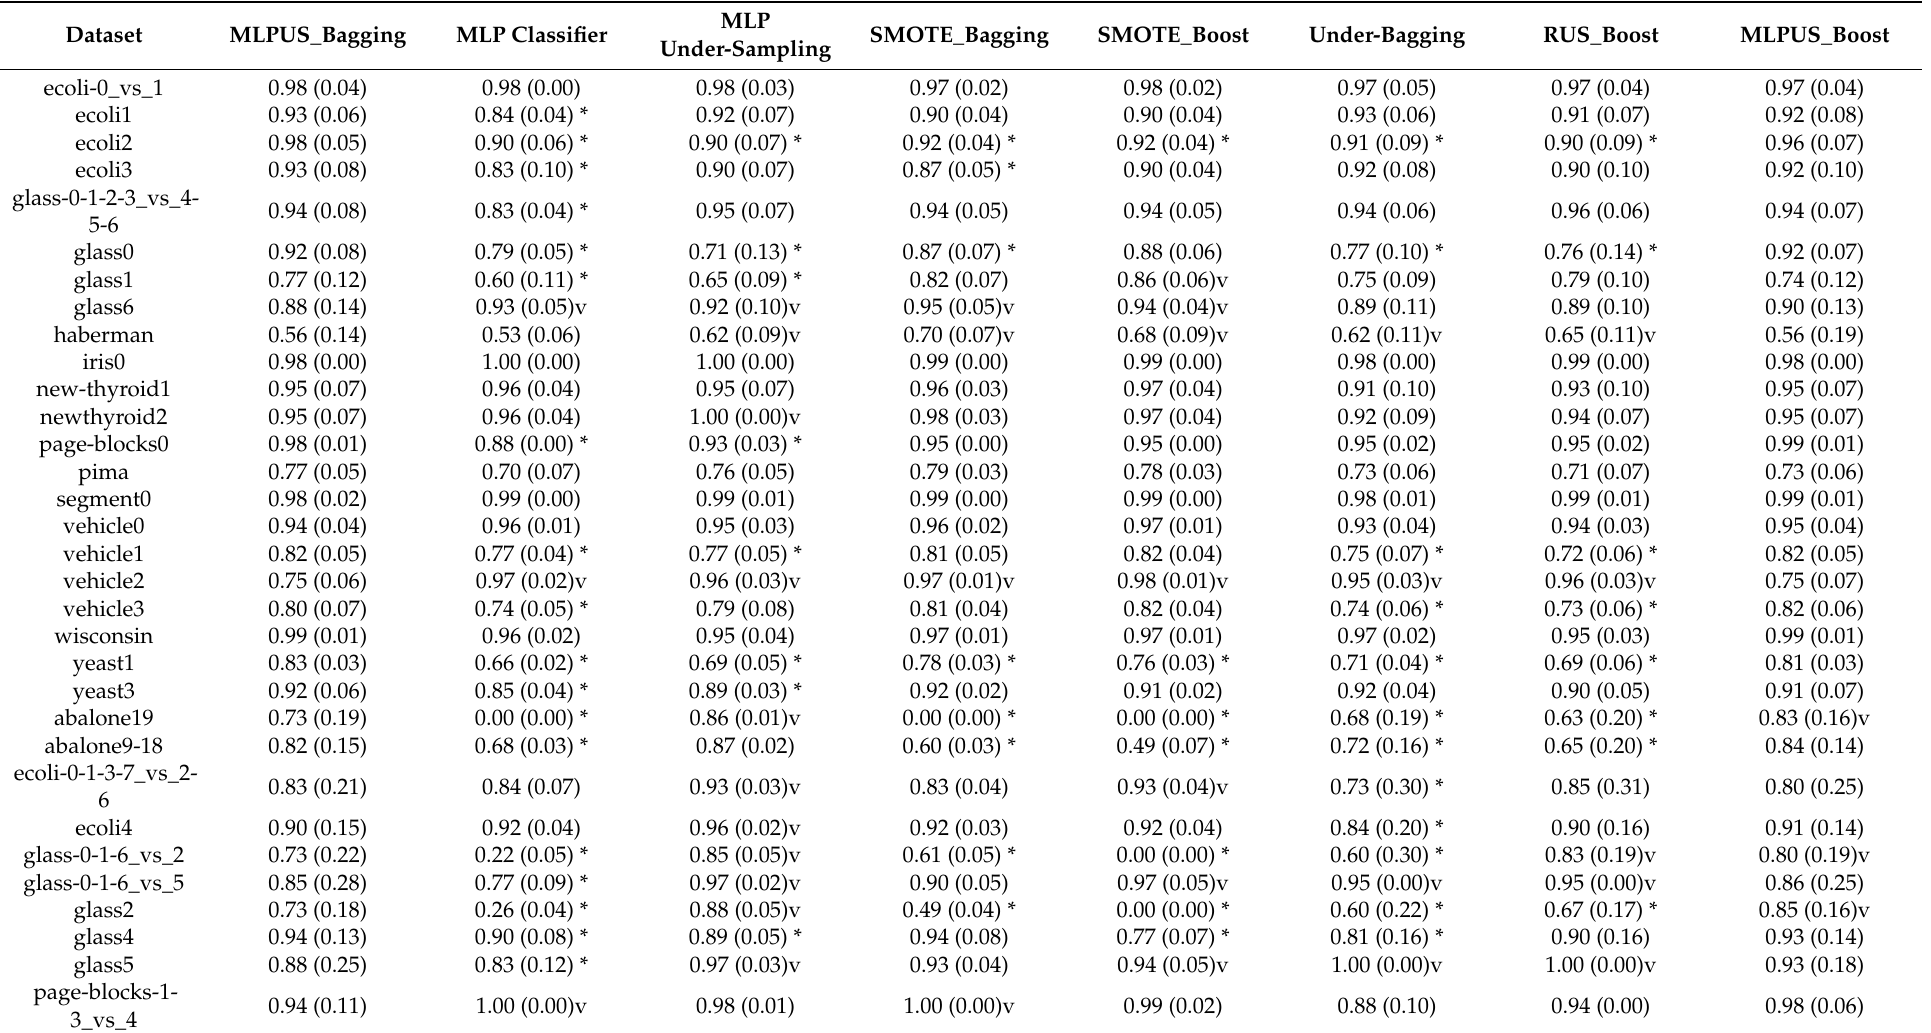
Table 6. G-Mean Results of all methods for all